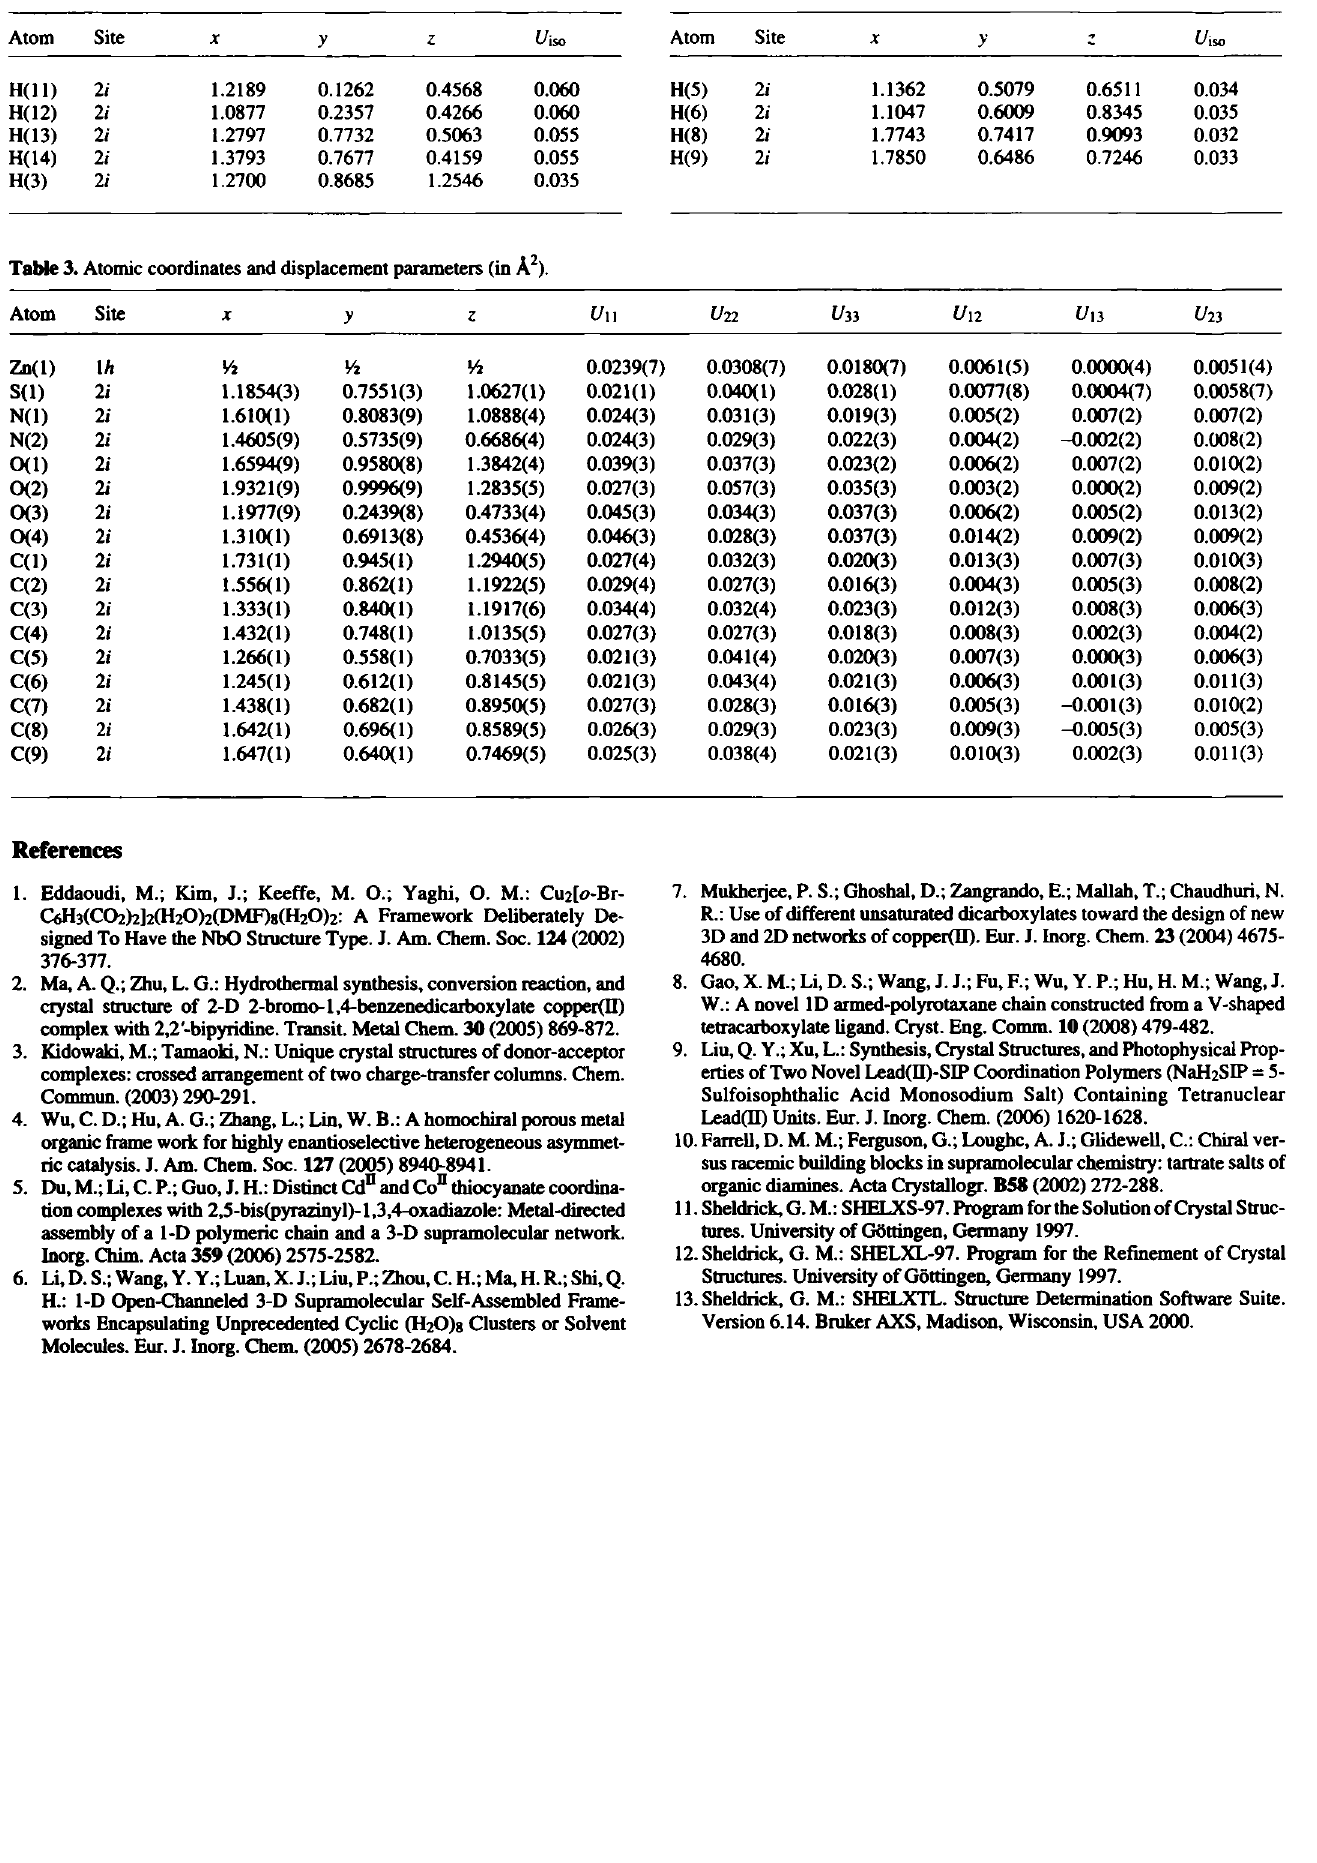
Table 3. Atomic coordinates and displacement parameters (in À 2